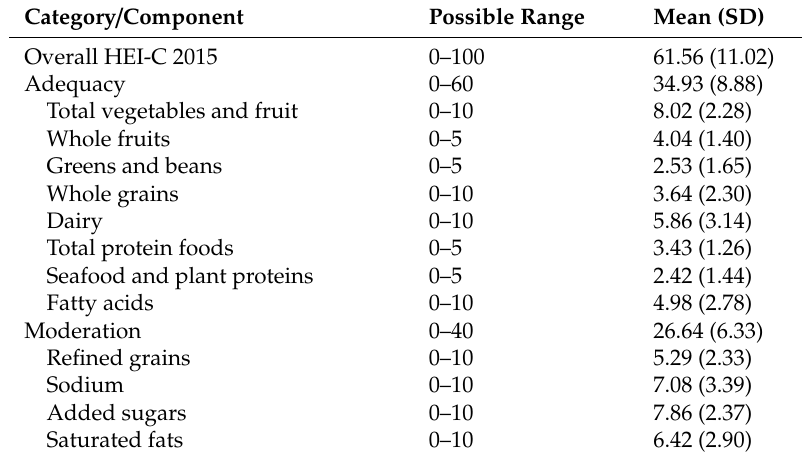
Table 2. Average HEI-C 2015 and component scores of ATP participants ( n =